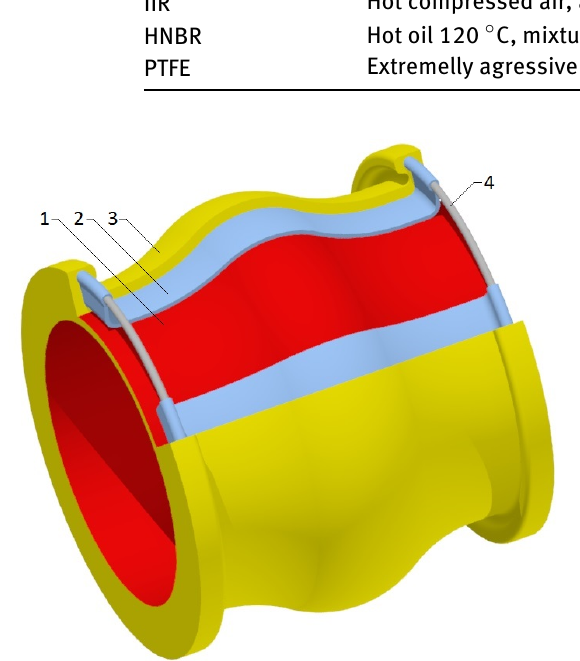
Figure 2: The design of elastic diaphragm: 1-internal layer; 2- reinforcing layer; 3-external layer; 4-metallic wire